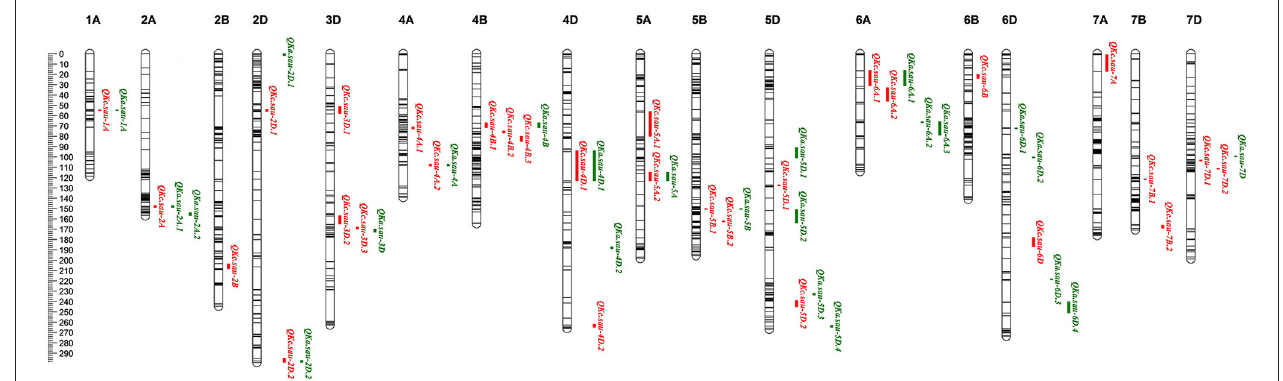
FIGURE 2 | The additive QTLs for kernel area (KA) and kernel circumference (KC) in the genetic map. Red for KC and green for KA. Thirty KC and 24 KA QTLs were mapped to chromosomes 1A, 2A, 2B, 2D, 3D, 4A, 4B, 4D, 5A, 5B, 5D, 6A, 6B, 6D, 7A, 7B, and 7D, respectively. The major and stable QTLs QKc.sau.6A.1 (23.12–31.64cM, closet marker: AX-109894590) and QKa.sau.6A.2 (66.00–66.57cM, closet marker: AX-108852271) were mapped on 6A chromosome. The positions, interval, and closet markers of other QTLs are listed in Table 3 . The scale label of the linkage map is 2cM, which is showed in the left.